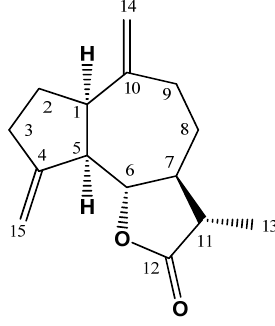
Figure 1. Chemical structure of ML.